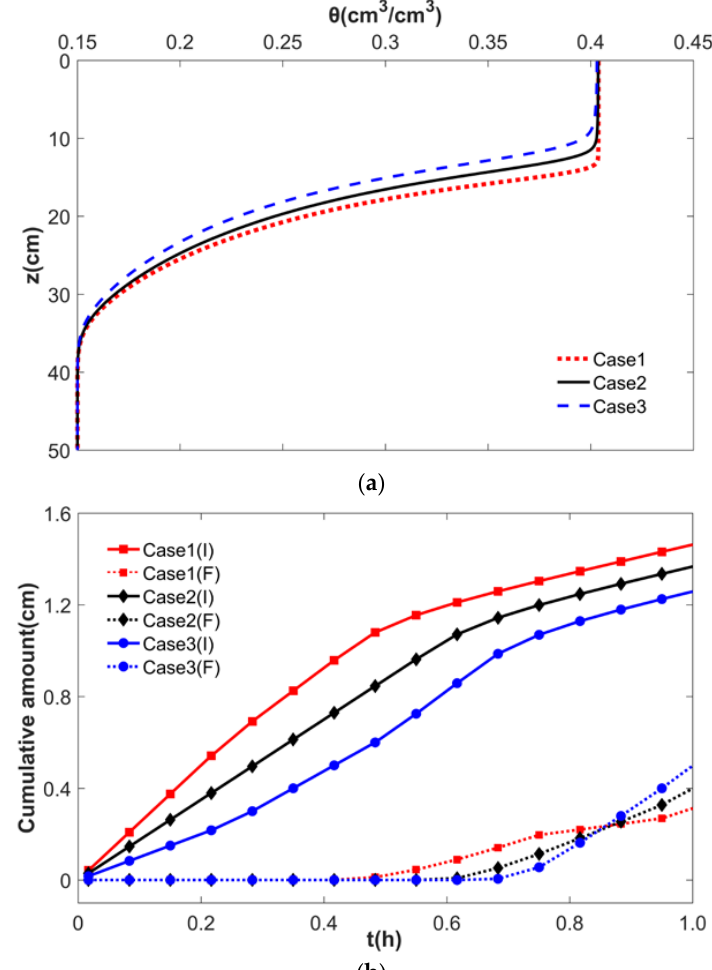
Figure 10. Calculation results with three cases. ( a ) Profiles of soil water content at t = 1 h; ( b ) Cumulative infiltration and cumulative runoff versus